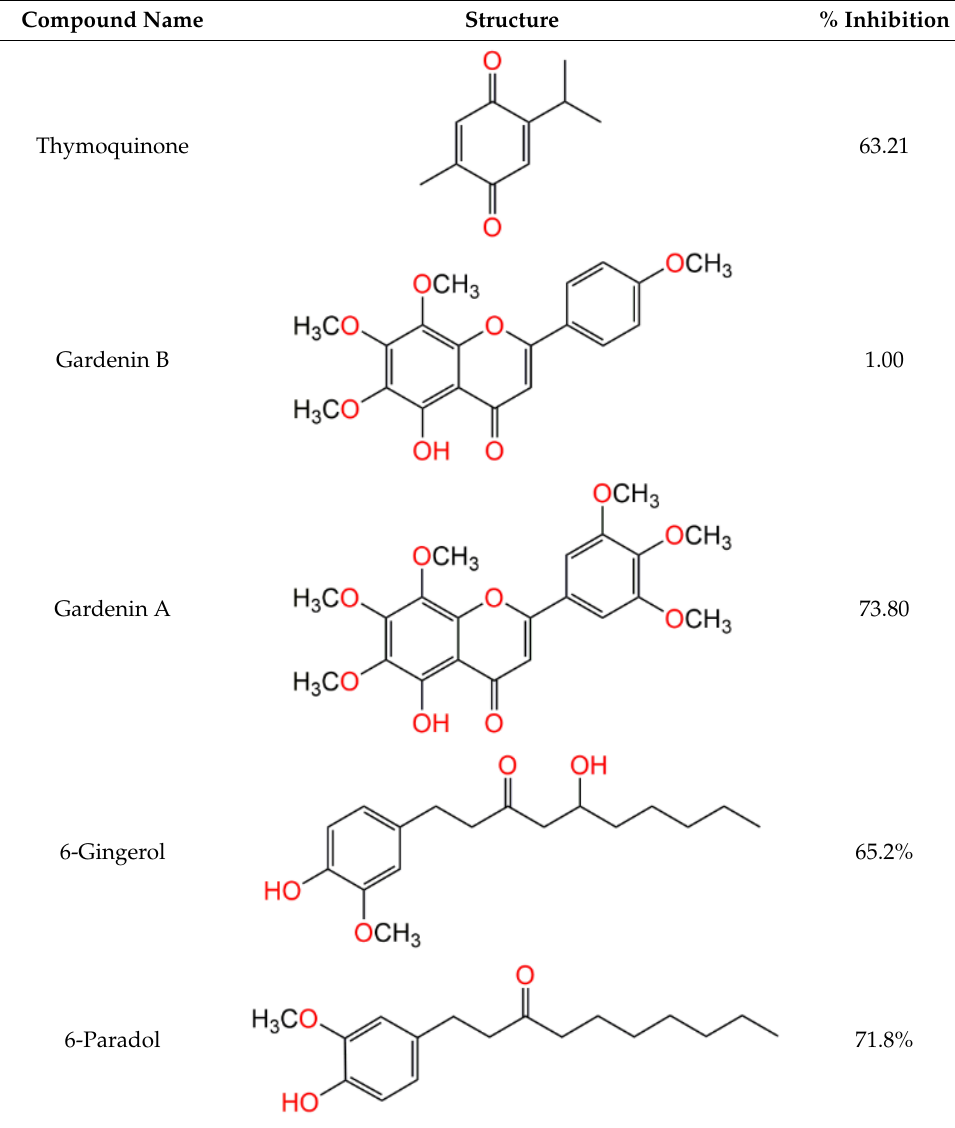
Table 3. IC 50 of isolated compounds compared to GC376 (Standard M PRO protease enzyme inhibitor) on SARS-CoV-2 viral main